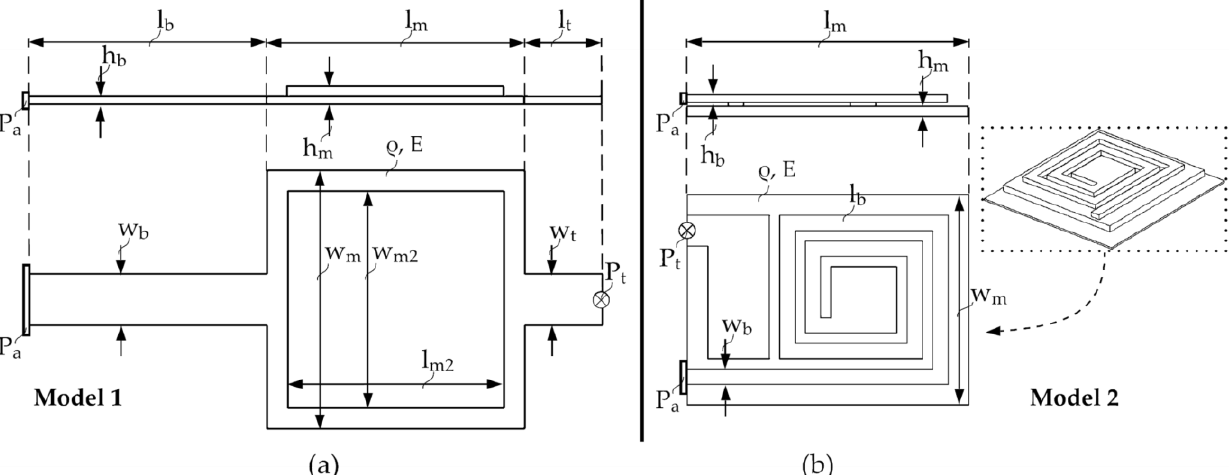
Figure 6. Two concepts of the sensor structure with parameters 𝑙 𝑏 beam length, ℎ 𝑏 beam thickness, 𝑤 𝑏 beam width, 𝑙 𝑚 mass length, ℎ 𝑚 mass thickness, 𝑤 𝑚 mass width, 𝜌 material density, 𝑙 𝑡 tunneling beam length, 𝑤 𝑡 tunneling beam width, 𝑃 𝑎 system anchor point, and 𝑃 𝑡 point of tunneling electrodes. ( a ) Single beam model. ( b ) Spiral beam model.